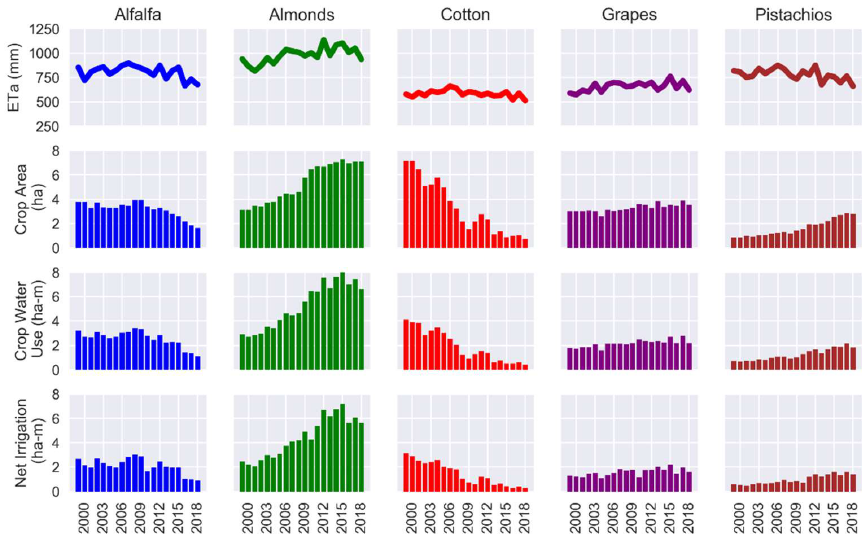
Figure 5. The top five crops in Kern County from 1999 to 2018 showing the SSEBop ETa mean (in mm) for the USDA-NASS CDL crop type, the bias-corrected area estimate (in hectares), water use volume (ha-m) and the net irrigation (ha-m) in hectare-meters. The area, water use, and net irrigation are scaled by 10,000 (i.e., 4 ha-m corresponds to 40,000 ha-m). 1 hectare = 2.47 acres. 1 hectare-meter = 8.107 acre-feet.